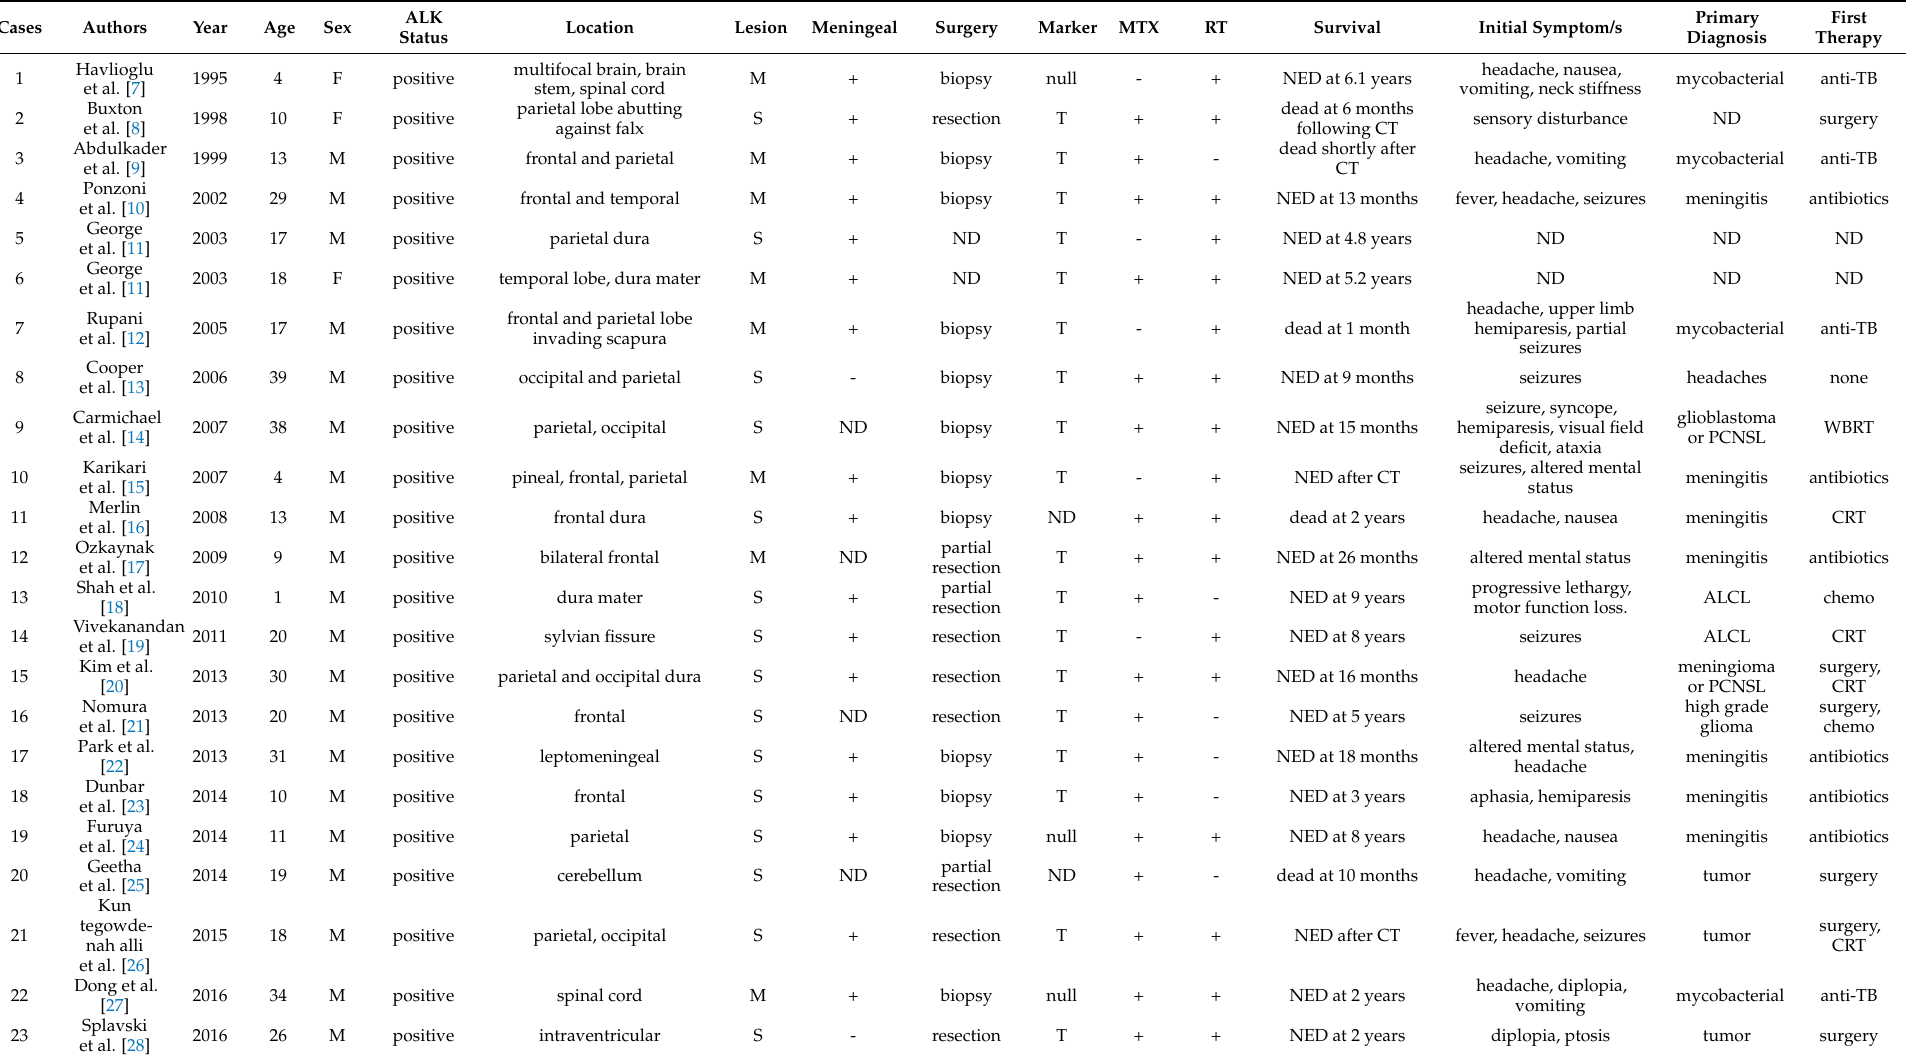
Table 1. List of reported cases of primary anaplastic large cell lymphoma of the central nervous system in the current